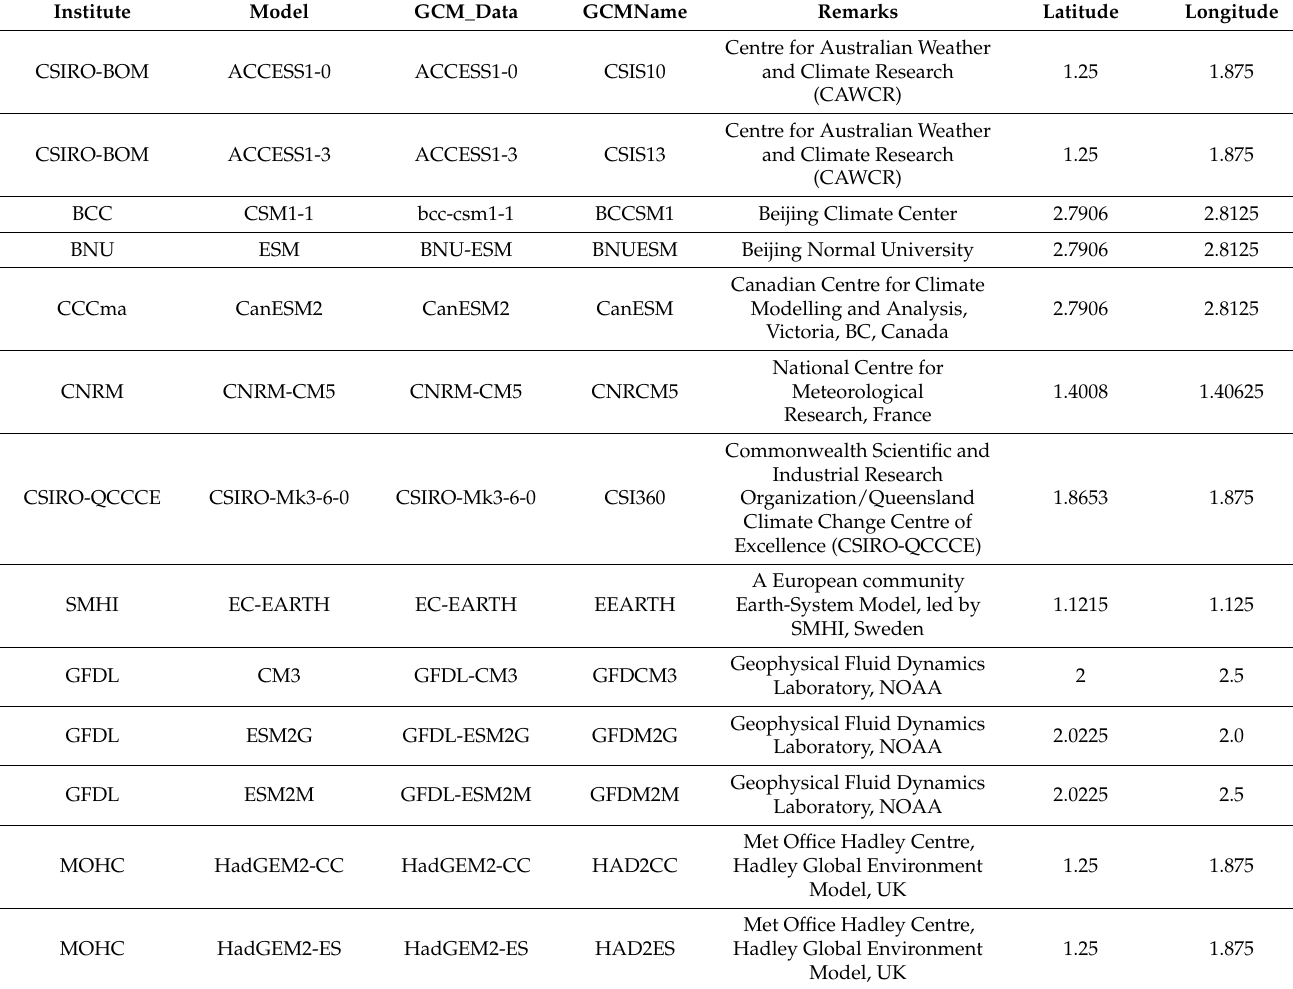
Table 1. Original spatial resolution of the 20 Global Circulation Models (GCMs) used in this study (1981–2100). Institute Model